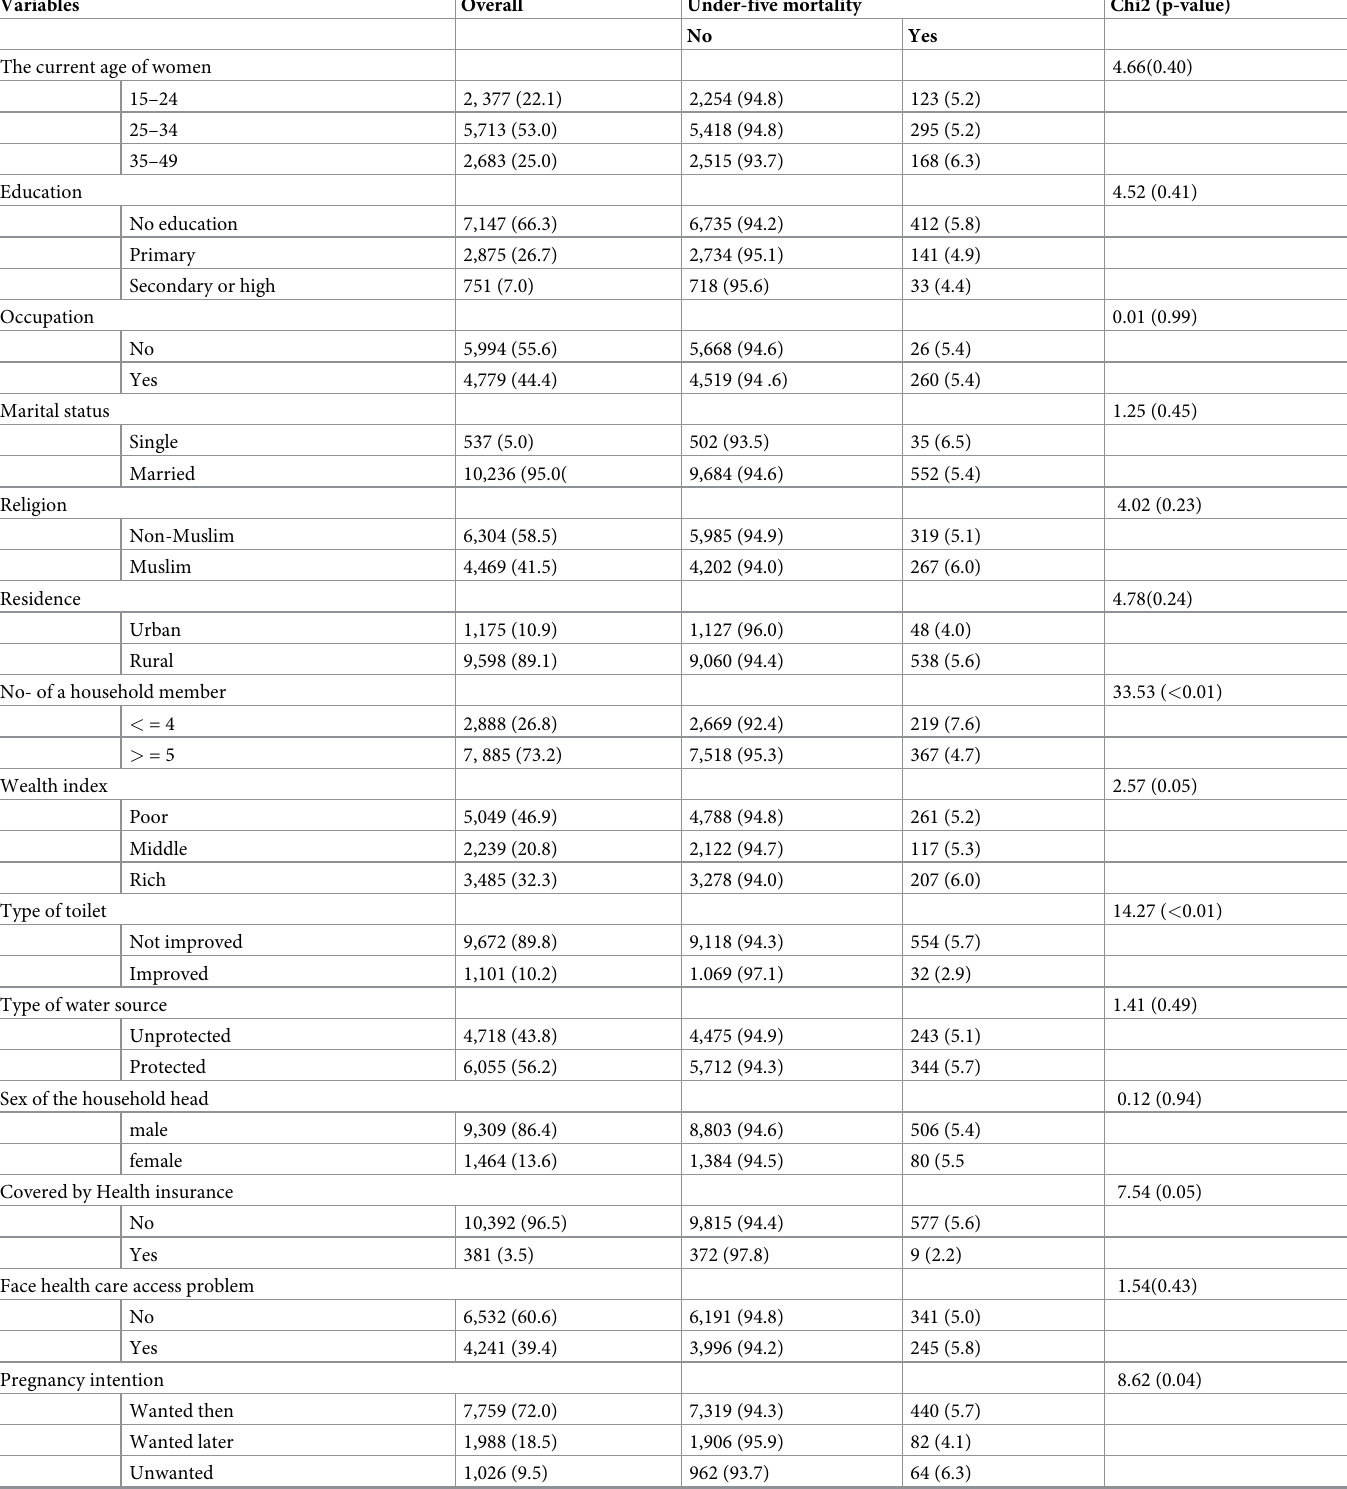
Table 1. Characteristics of the study participants by under-five mortality (n = 10,773), EDHS